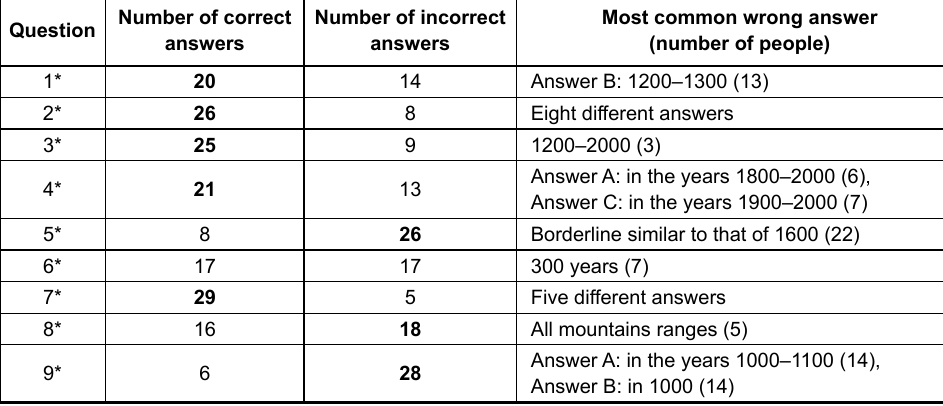
Table 4. The analysis results for responses of G3 respondents Number of correct Question